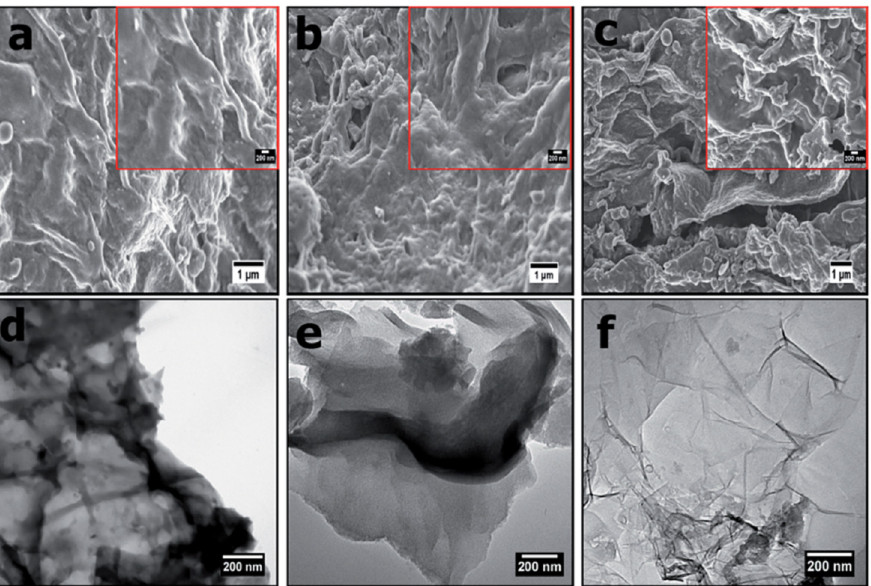
Figure 13. Images of onion peel-derived activated carbon: ( a ) SEM image of OP AC-600 °C, ( b ) SEM image of OP AC-700 °C, ( c ) SEM image of OP AC-800 °C, ( d ) TEM image of OP AC-600 °C, ( e ) TEM image of OP AC-700 °C, and ( f ) TEM image of OP AC-800 °C. The insets in ( a – c ) are the SEM images taken at higher magnifications. Reprinted from [23], ©2020 The Authors.